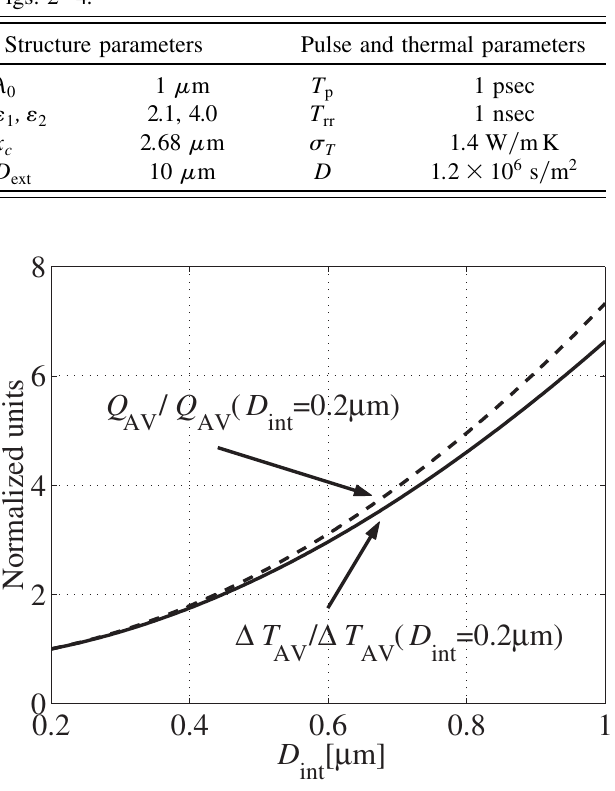
are given in Table rr